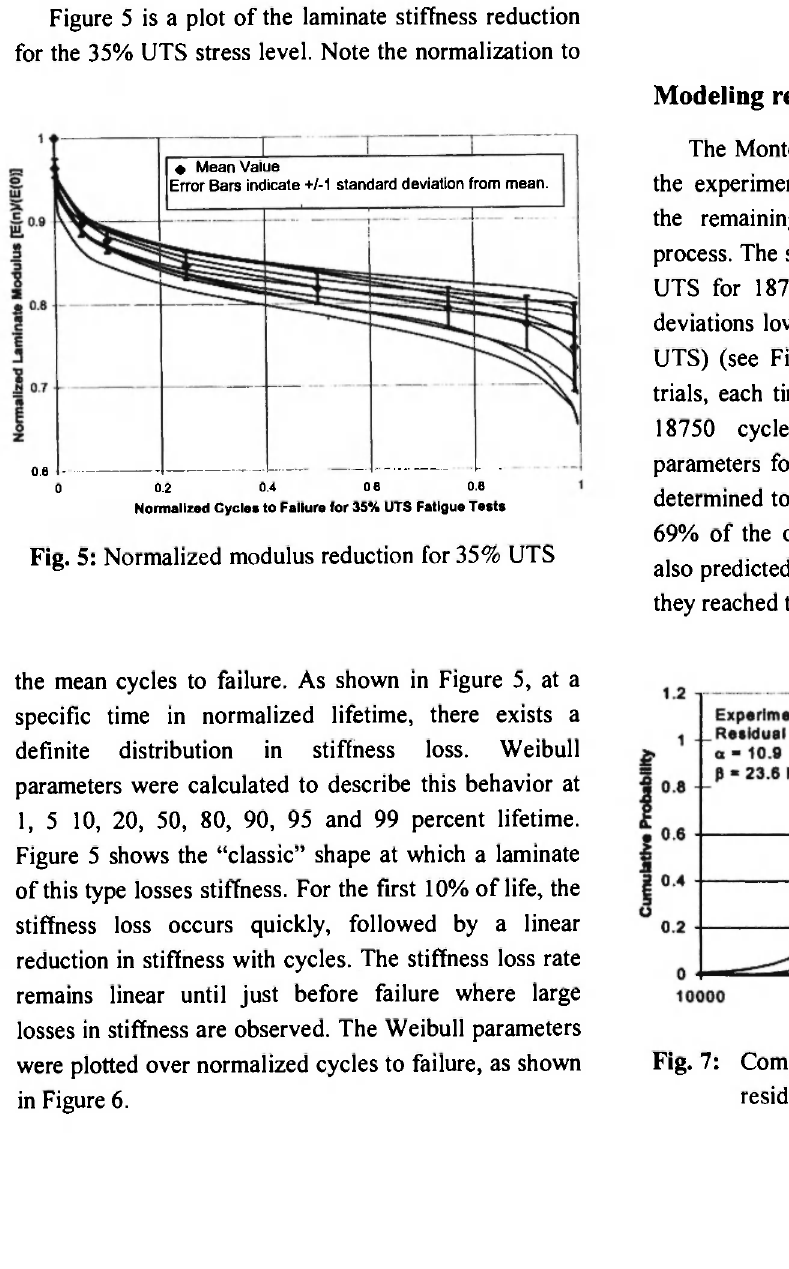
Fig. 6: Evolution of Weibull parameters with normalized cycles